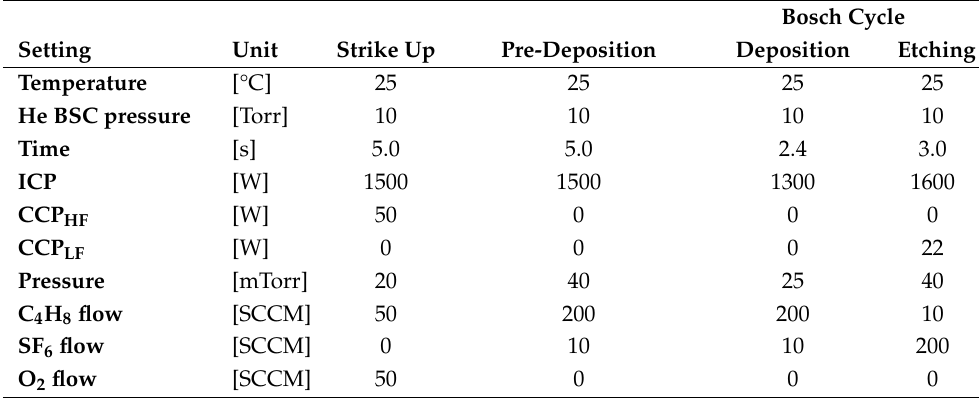
Table 1. Starting recipe of the Bosch-based HAR DRIE in the PlasmaPro100 Estrelas system. The CCP LF was boosted for 30% of the etch-cycle time to ensure FC